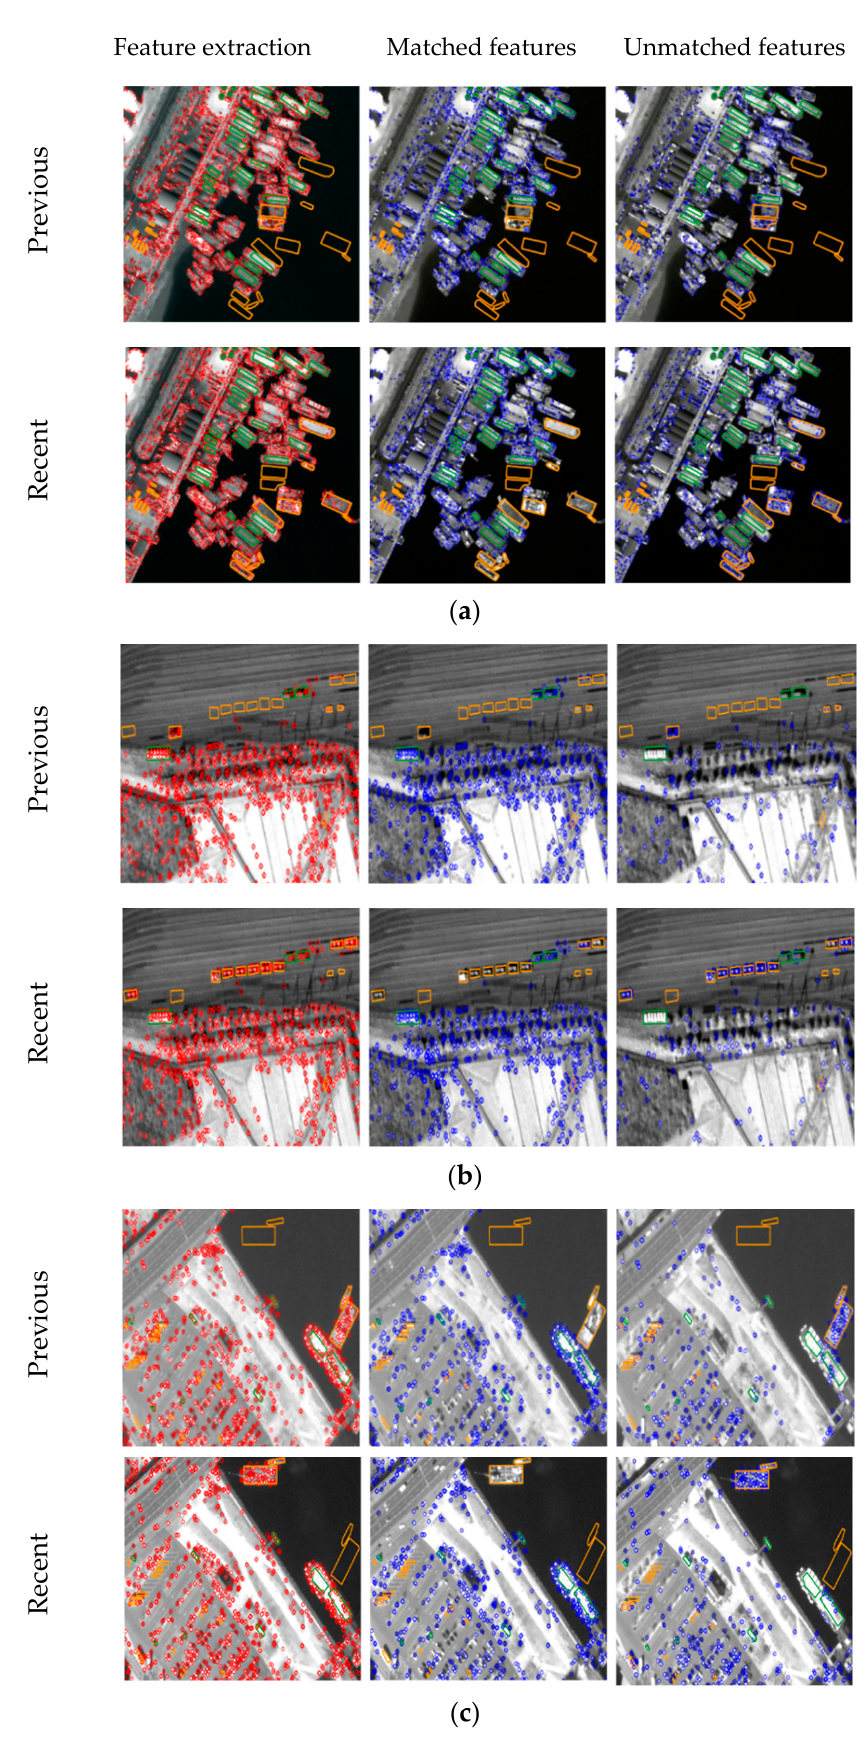
Figure 7. Feature extraction and matching results for ( a ) Incheon, ( b ) Chilgok, and ( c ) Seoul.